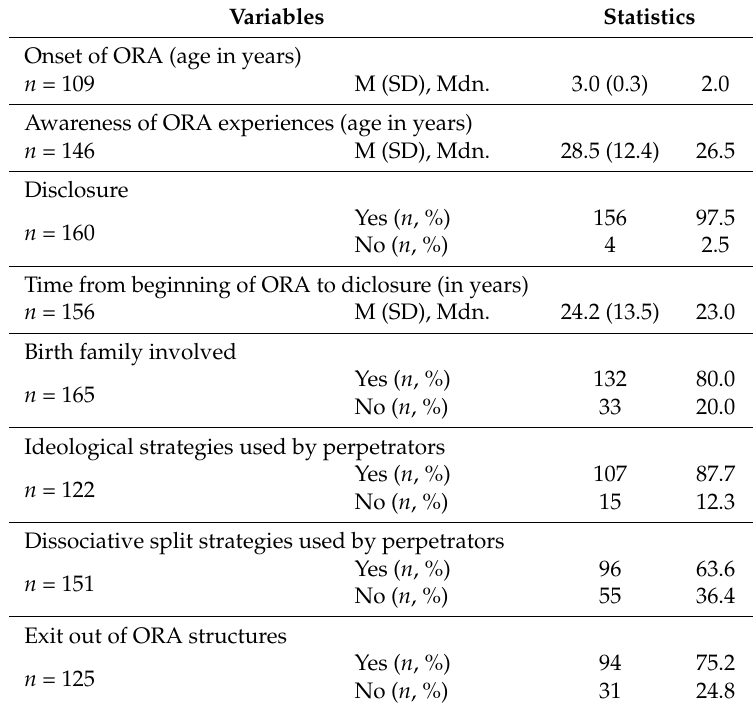
Table 2. Experiences of self-identified victims in the ORA context ( n = 165). Variables